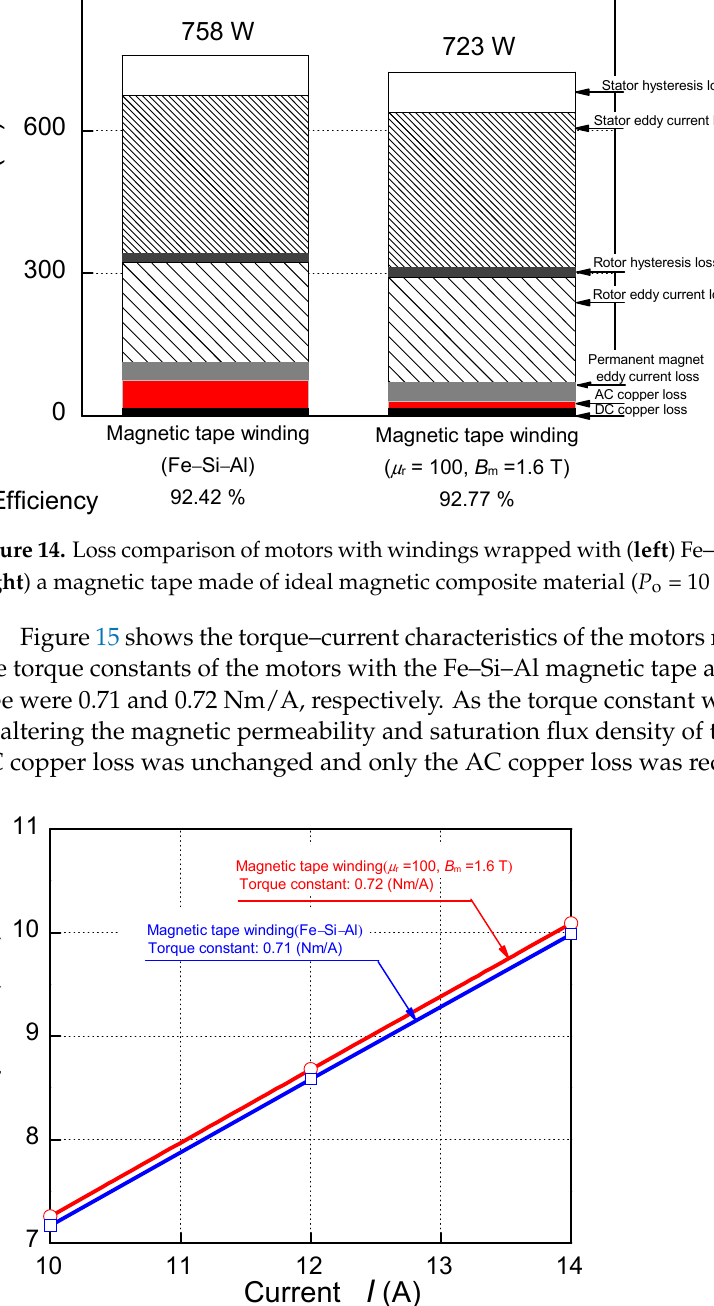
( c ) Figure 16. Comparison of tape-dependent motors losses ( P o = 10 kW, N r = 10,000 rpm). ( a ) efficiency; ( b ) copper loss; ( c ) iron loss. 4.2. Effect of Carrier Harmonics on Motor Losses Panels (a) and (b) of Figure 17 show the distribution of magnetic flux density in the Fe–Si–Al tape-wound motor and a virtual material tape-wound motor. The higher specific permeability of the virtual material (compared to the Fe–Si–Al tape) induced leakage flux in the teeth; consequently, the magnetic flux density was higher in the teeth of the virtual material tape-wound motor than in the teeth of the Fe–Si–Al tape-wound motor. The higher flux density in the teeth slightly increased the torque of the motor. The torques of the Fe–Si–Al tape-wound motor and the virtual material tape-wound motor were 9.37 and 9.41 Nm, respectively.